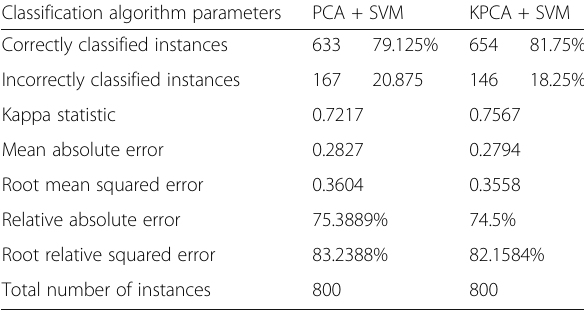
Table 2 Experimental results compared with PCA + SVM, KPCA